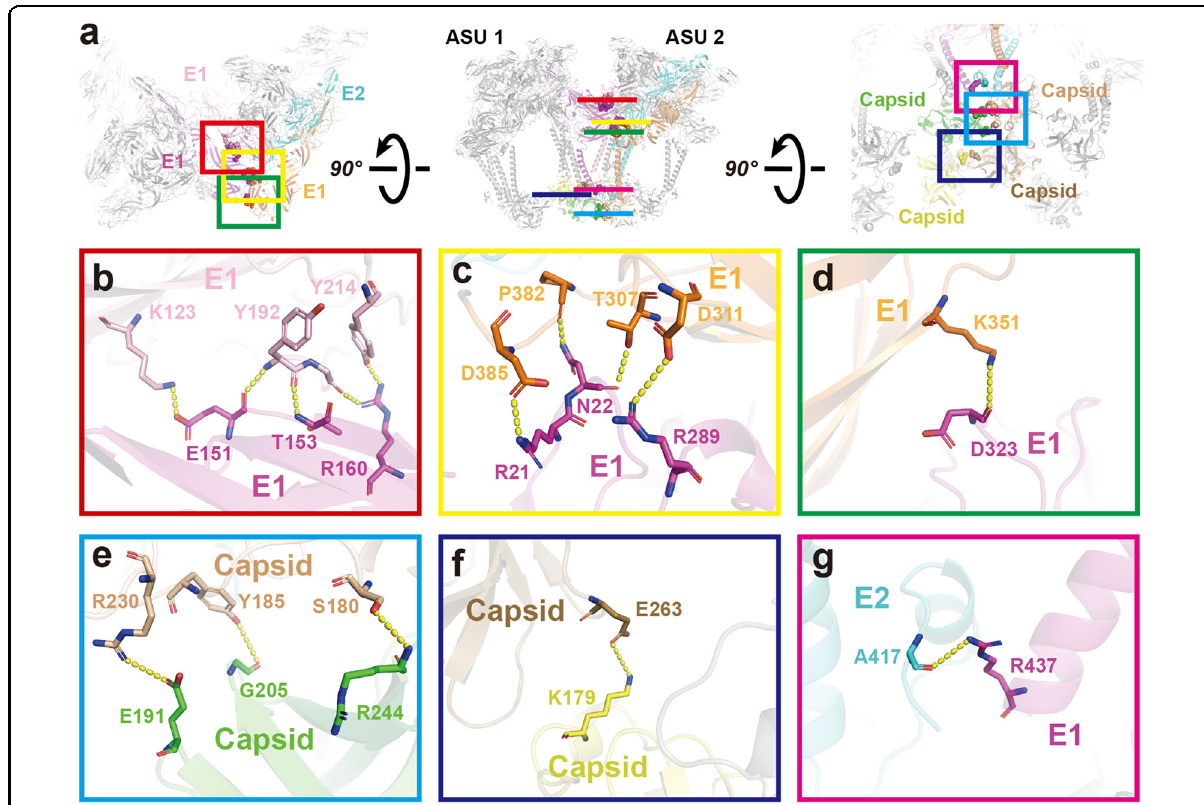
Fig. 4 Interactions of GETV protein domains between two ASUs. a The top, side, and bottom view of two adjacent Q-trimers. The E1, E2 and capsid proteins participating in the interactions are colored; other proteins are gray. Residues involved in the interaction are displayed as spheres, in the same color as the corresponding proteins. b – d Zoomed-in views of the interactions between E1 (magenta) of ASU1 and E1 (pink) of the neighboring E1 – E2 – capsid heterotrimer, along with another E1 (orange) of the heterotrimer in ASU2. e , f Two sets of capsid – capsid interactions occurring between the contiguous capsids of ASU1 and ASU2. Green and yellow capsids are in the ASU1, and the other two capsids are in the ASU2. g Interaction region between E1 (magenta, the same E1 protein in b , c and d ) and E2 (cyan, the same E1 heterotrimer in c and d ). The yellow dashed lines indicate the distance between the atoms involved in the